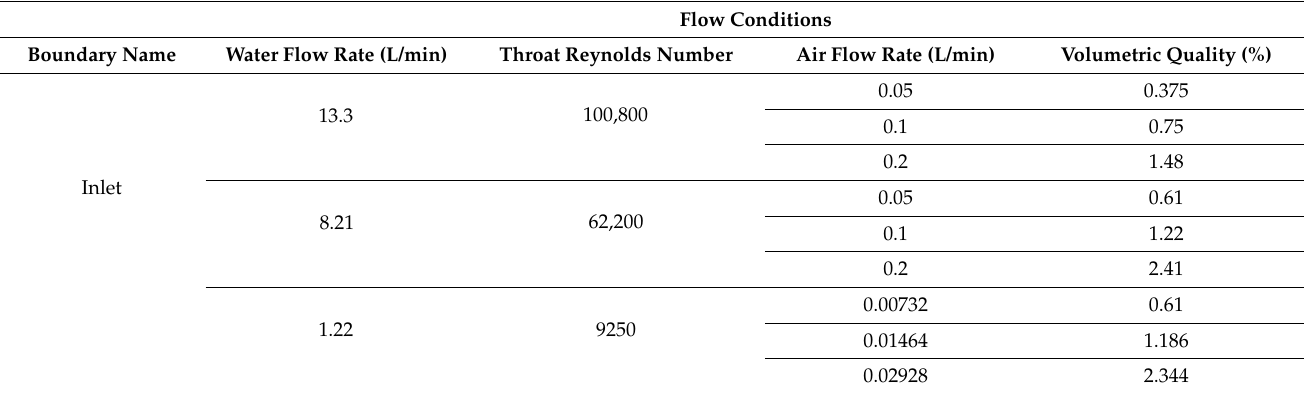
Table 4. The water and air flow rates used to validate the